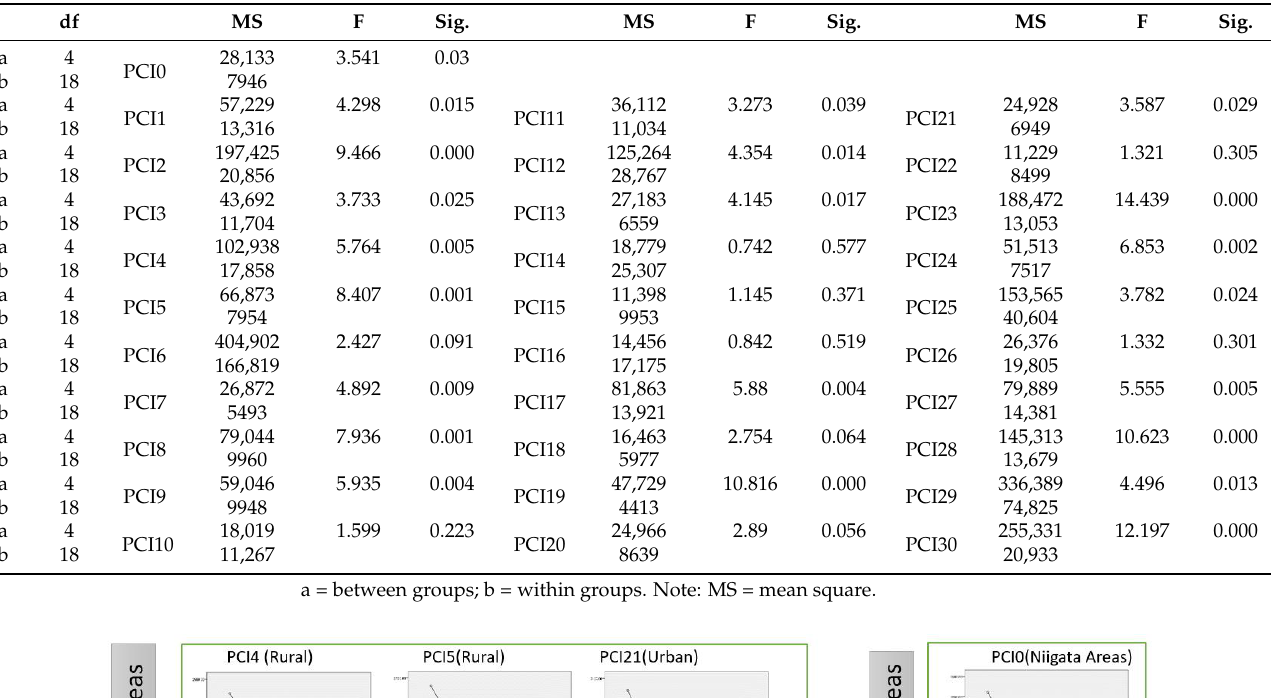
Table 6. ANOVA (Per Capita Income).